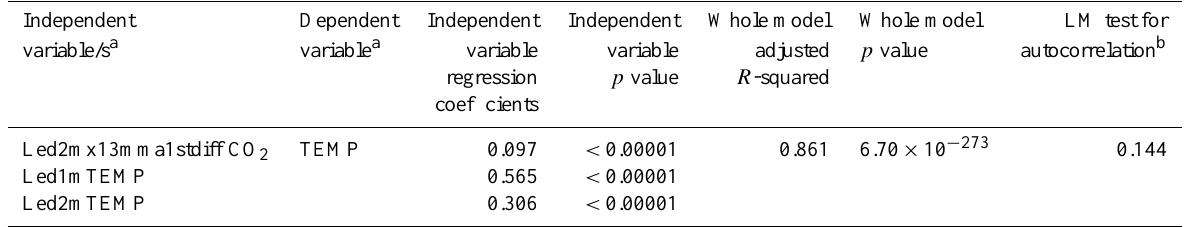
Table 4. OLS dynamic regression between first-difference atmospheric CO 2 and global surface temperature for monthly data for the period 1959–2012, with autocorrelation taken into account Independent Dependent Independent Independent Whole model Whole model variable/s a variable a variable variable p value